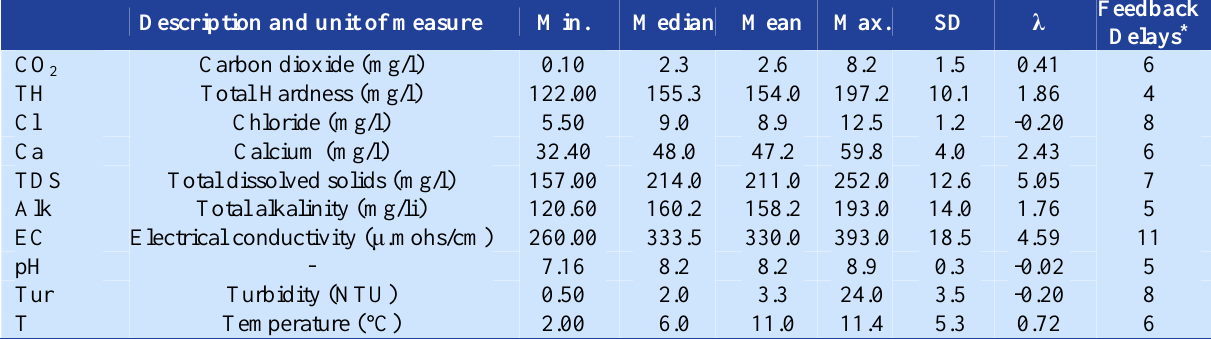
* Feedback delays: The number of auto-regressive series lags as inputs of the NAR neural network; SD: Standard deviation; TH: Total hardness; TDS: Total dissolved solids; Alk: Alkalinity; EC: Electrical conductivity; Tur: Turbidity; T: